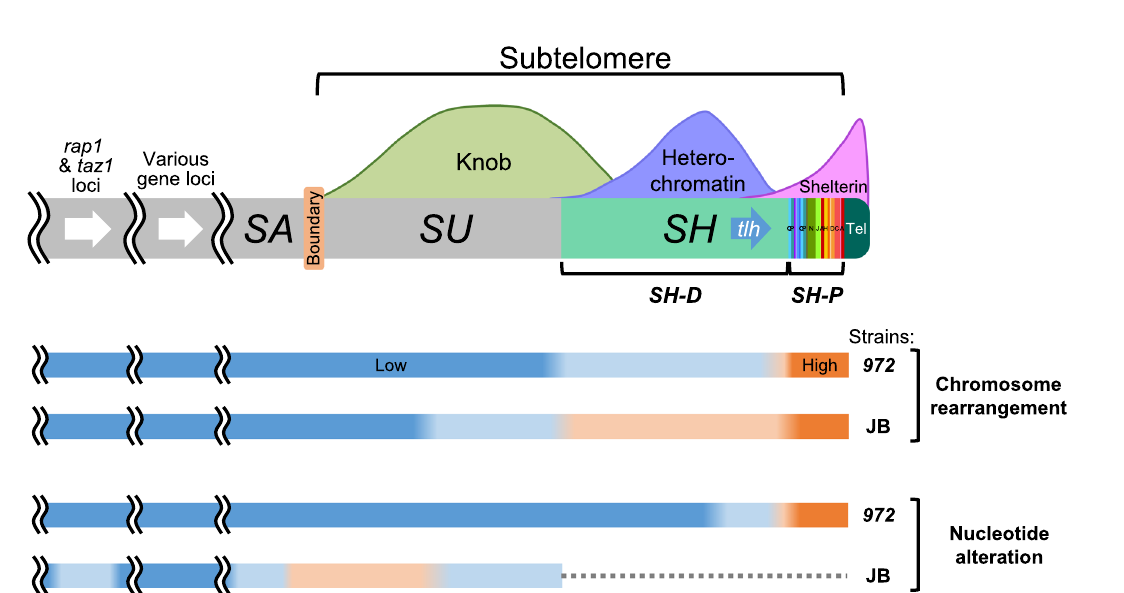
Fig. 9 Summary of features of S. pombe subtelomeres. The S. pombe SH region is composed of two parts: the SH-P region with a mosaic of multiple segments, and the SH-D region with multiple blocks and boxes containing deletions and insertions. Colors of bars indicate relative rates of chromosome rearrangement or nucleotide alteration versus PomBase (orange, high rate; blue, low rate). The SH-P region shows high rates of chromosome rearrangement and nucleotide alteration even between the 972 strains ( 972SD4 and JB22 vs. PomBase), whereas the SH-D region shows lower rates of these changes compared with those in the SH-P region. The SU , boundary, and SA regions and the rap1 and taz1 loci also exhibit medium levels of these changes in the JB strains that are phylogenetically distant from 972 . Thus, chromosomal regions around the subtelomeres (and the rap1 and taz1 loci) are prone to genome diversity. Dotted line indicates a region that was unable to be analyzed with the NGS